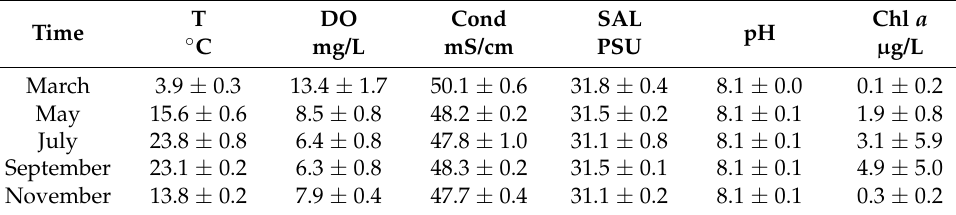
Table 1. The average physicochemical parameters in Sishili Bay in 2018.